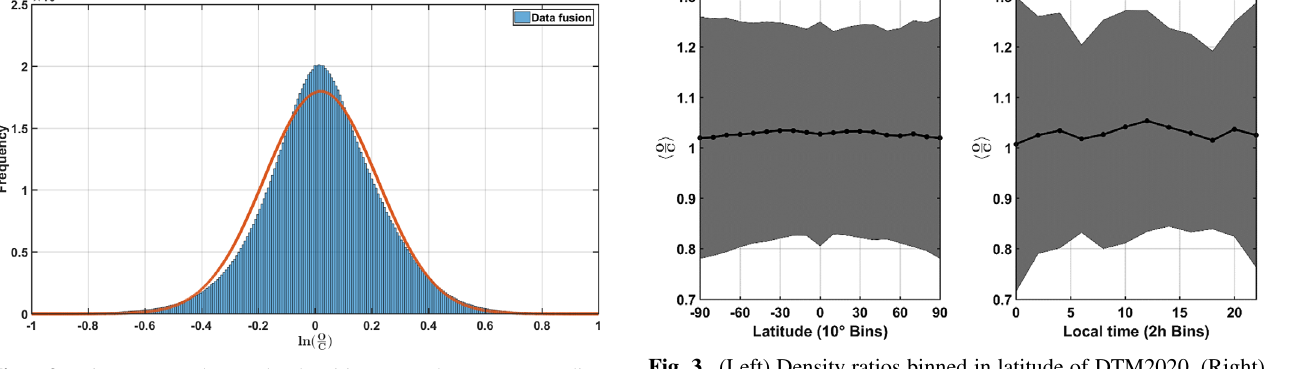
Fig. 2. Histogram observed densities to the corresponding DTM2020 model densities (log scale). Fusion data integrated GOCE, CHAMP, GRACE, and SWARM neutral densities datasets. The normal distribution N ( l = 0.02, r = 0.2) is